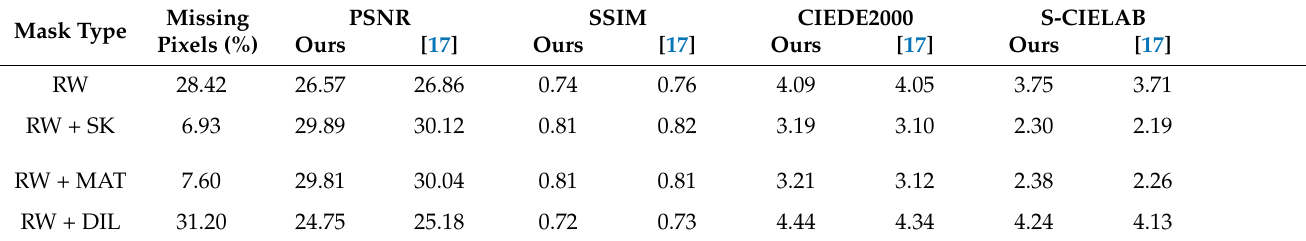
Table 1. Peak Signal-to-Noise Ratio (PSNR), Structural Similarity Index (SSIM), CIEDE2000, and S-CIELAB metrics between the ground-truth test images and the inpainted results, presented for each mask type. For PSNR & SSIM, higher values mean better closer resemblance to the ground-truth. For CIEDE2000 and S-CIELAB, higher values correlate with a higher colorimetric distance with respect to